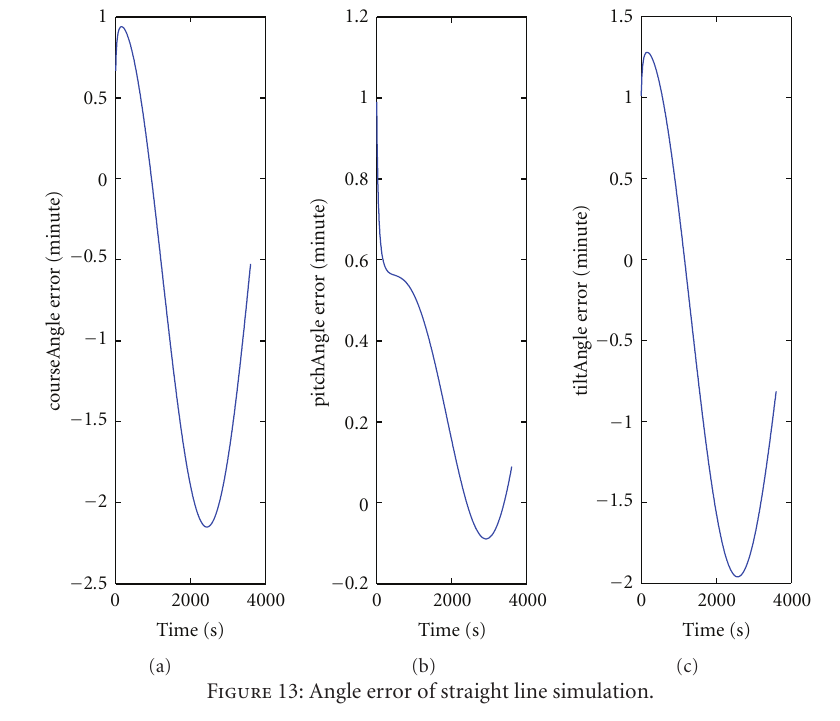
Figure 13: Angle error of straight line simulation.